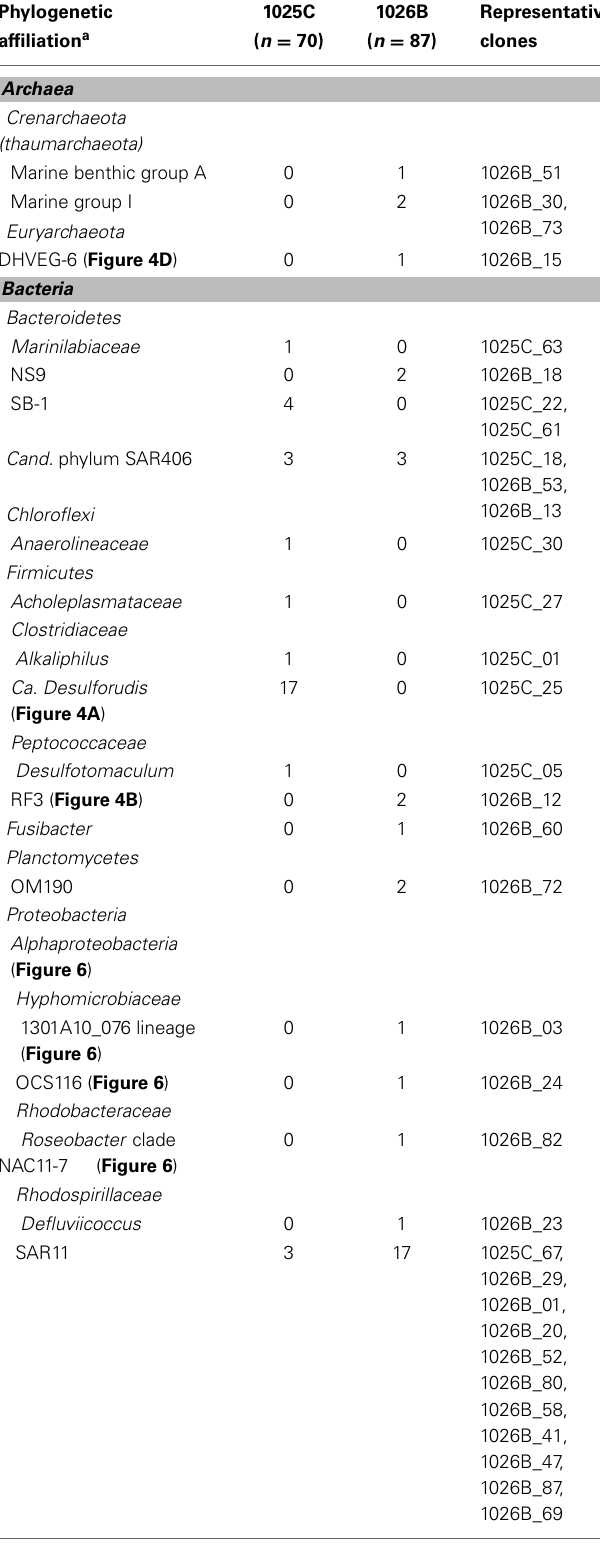
Table 2 | Relative abundance of SSU rRNA gene clones from